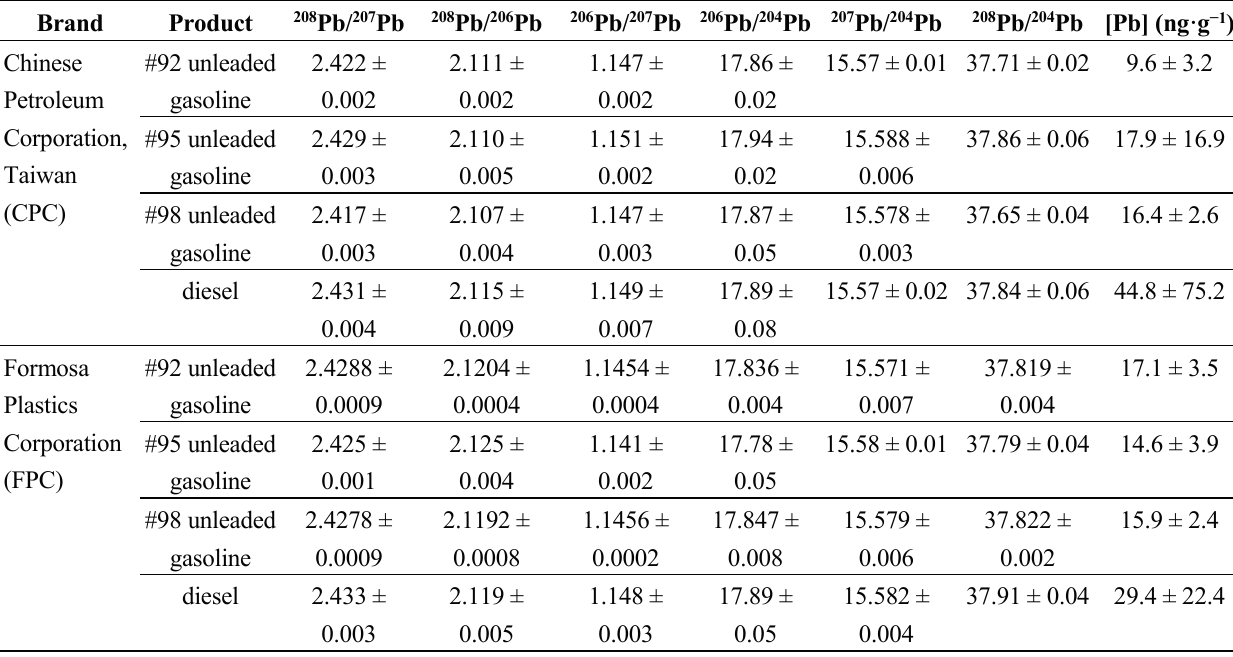
Figure 1. History of the use of petroleum fuels in Taiwan (data from [12]). Table 2. Summary of Pb isotopic characteristics and level in Taiwan’s fuel products (mean ± 1 S.D., n =